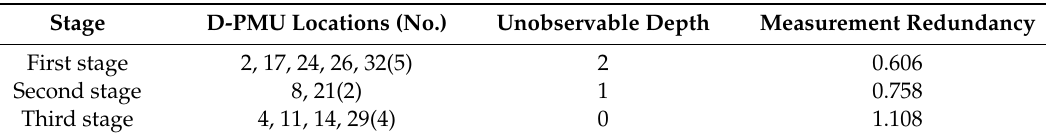
Table 5. Multistage D-PMU placement of IEEE 33 bus system.